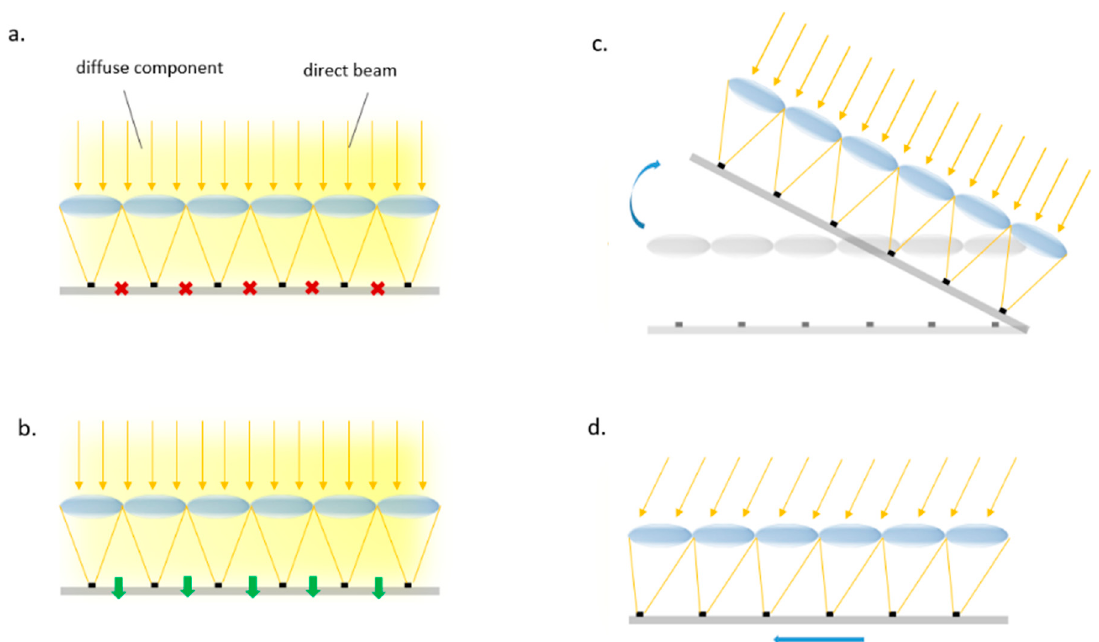
Figure 2. Contrast of conventional CPV with transparent, tracking-integrated CPV: ( a ) CPV cannot concentrate diffuse light and this component is lost; ( b ) in a transparent module, diffuse light passes through. ( c ) Conventional CPV tracks the sun by tilting the entire modules; ( d ) tracking-integrated CPV uses internal adjustments of the cells and optics, avoiding the need for an external sun-tracking device.